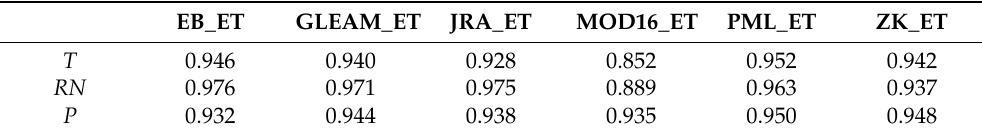
Figure 14. Time-series of climatic factors and ET products at monthly scale from 2003 to 2012. Table 5. Cosine similarity between climatic factors and ET products.